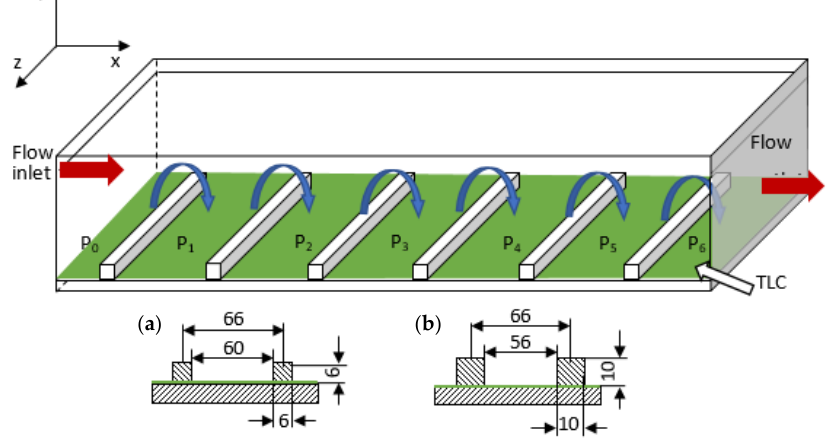
Figure 3. An example of the TLC test section configuration with the ribbed surface: P/e = 11 for configuration ( a ) and P/e = 6.6 for configuration ( b ), where P—pitch, e—rib height.